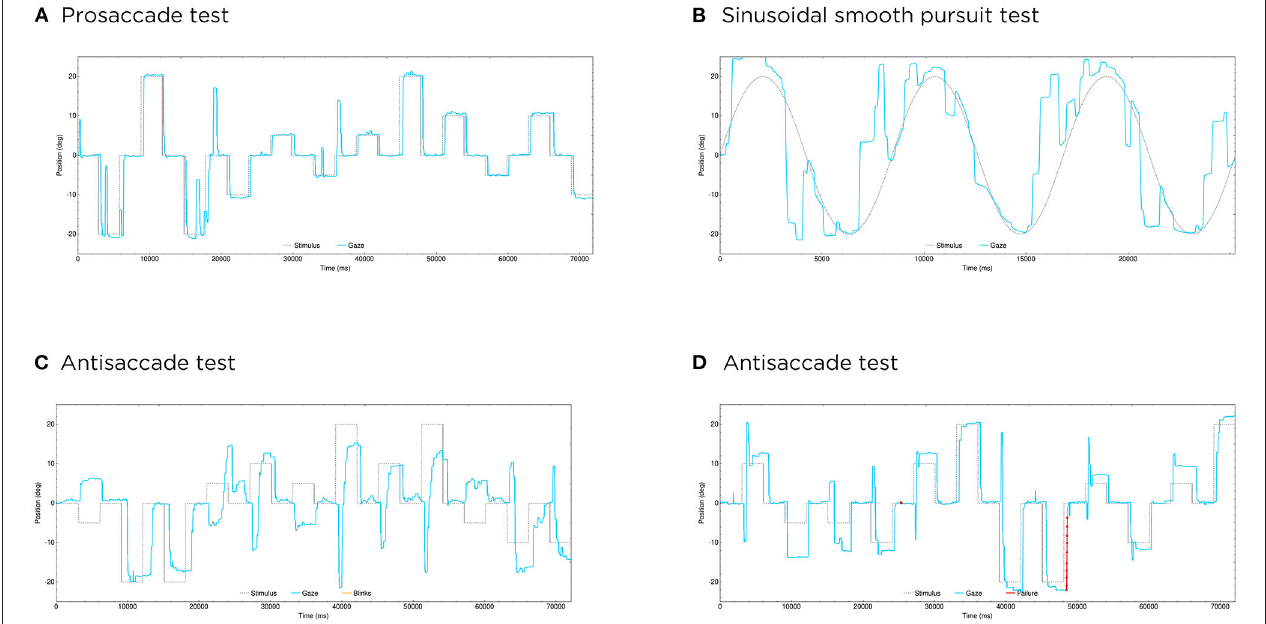
FIGURE 4 | Some clinical examples of oculomotor evaluations. (A,B) Show the performance of a patient with Alzheimer’s disease in an horizontal prosaccade test (A) and an horizontal sinusoidal smooth pursuit test (B) , with great difficulties in overlapping his gaze with the moving target in the latter. (C,D) Illustrate the different performance in the horizontal antisaccade test between a patient with bvFTD (C) , with some successful responses but that are slow and inaccurate; and a patient with svPPA (D) , who also makes some errors but followed by fast corrections in this case. In the ordinate axis, 0 indicates the center, positive values the right side and negative values the left side. Blue lines represent the patient’s ocular movement and dotted lines the expected location of the gaze, which corresponds to the target position in the prosaccade and sinusoidal smooth pursuit tests, and to the opposite position of the target in the antisaccade test. Blinks are marked in yellow and pupil detection failure (usually also due to blinks) in red. deg, degrees; ms,